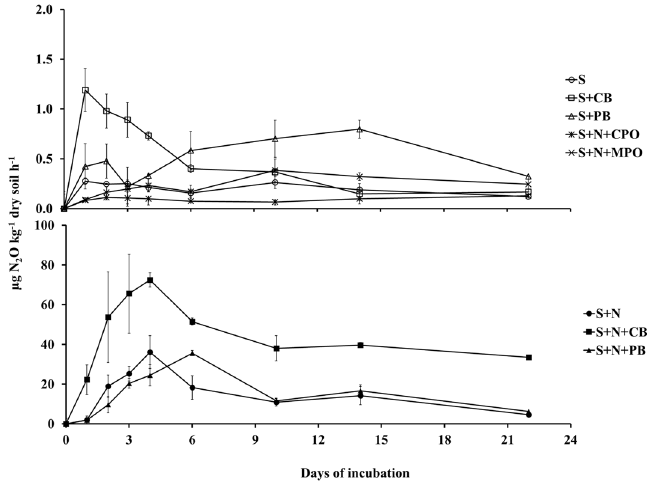
Figure 1. N 2 O production rate over the incubation period from mineral soil (MS). S = Control soil only; S + N = Control soil with N fertilizer; S + CB = Control soil with corn residue biochar; S + CB + N = Control soil with corn residue biochar and N fertilizer; S + PB = Control soil with pine bark biochar; S + PB + N = Control soil with pine bark biochar and N fertilizer; S + N + CPO = Control soil with N fertilizer and calcium